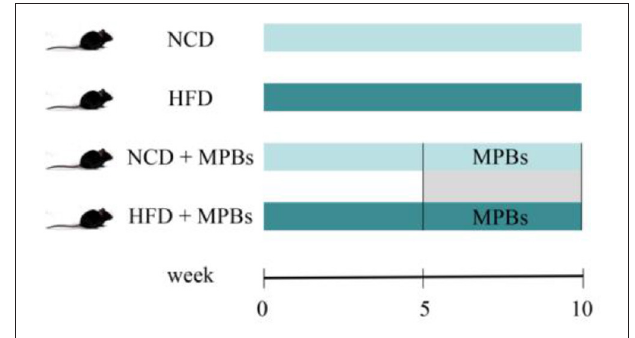
FIGURE 1 | Animal experiment